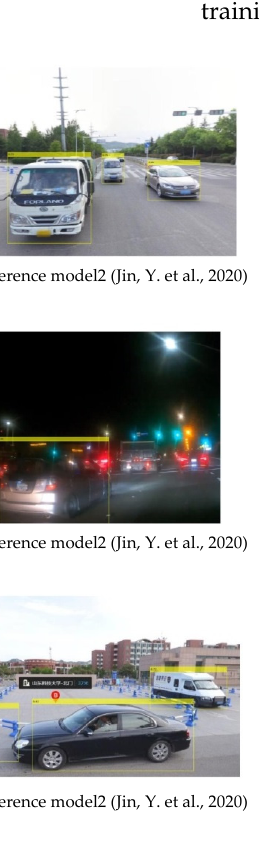
Figure 16. Actual test results. ( a ) Sample data 1 [21]; ( b ) Sample data 2 [21]; ( c ) Sample data 3